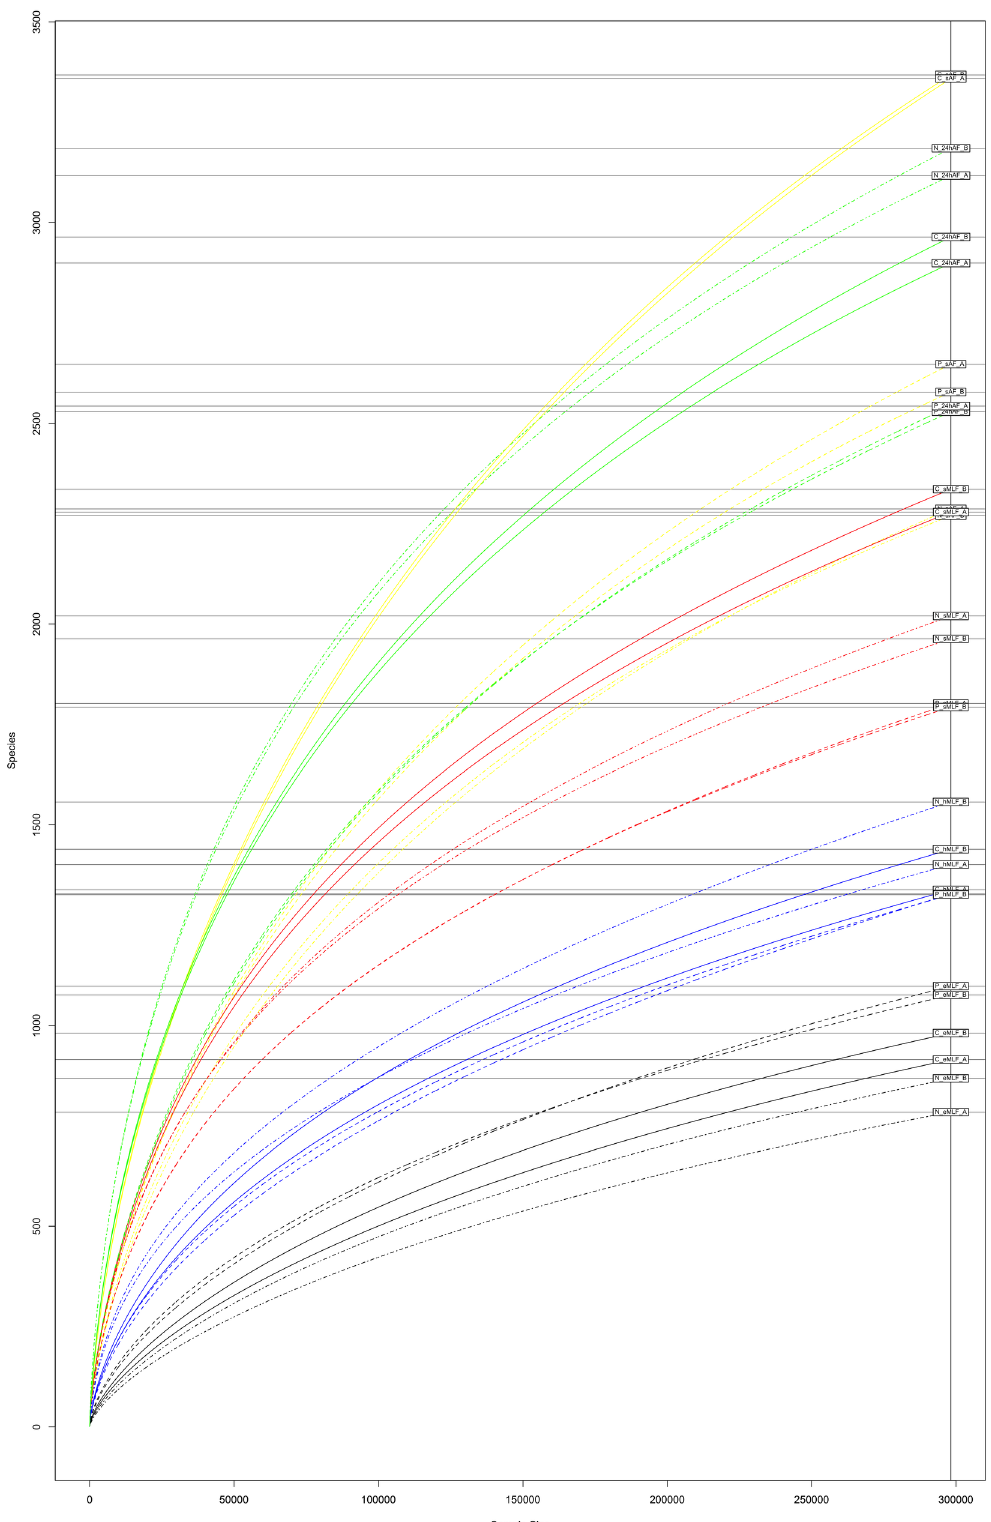
Fig 3. Rarefaction curves for the tested samples. Rarefaction curves calculated using the OTU matrix obtained from the Illumina MiSeq raw data by using QIIME are shown for all the analysed samples and sequencing runs.